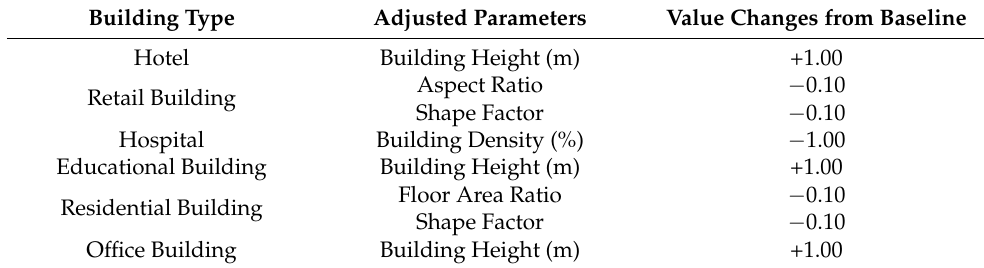
Table 4. Parameter settings for urban form